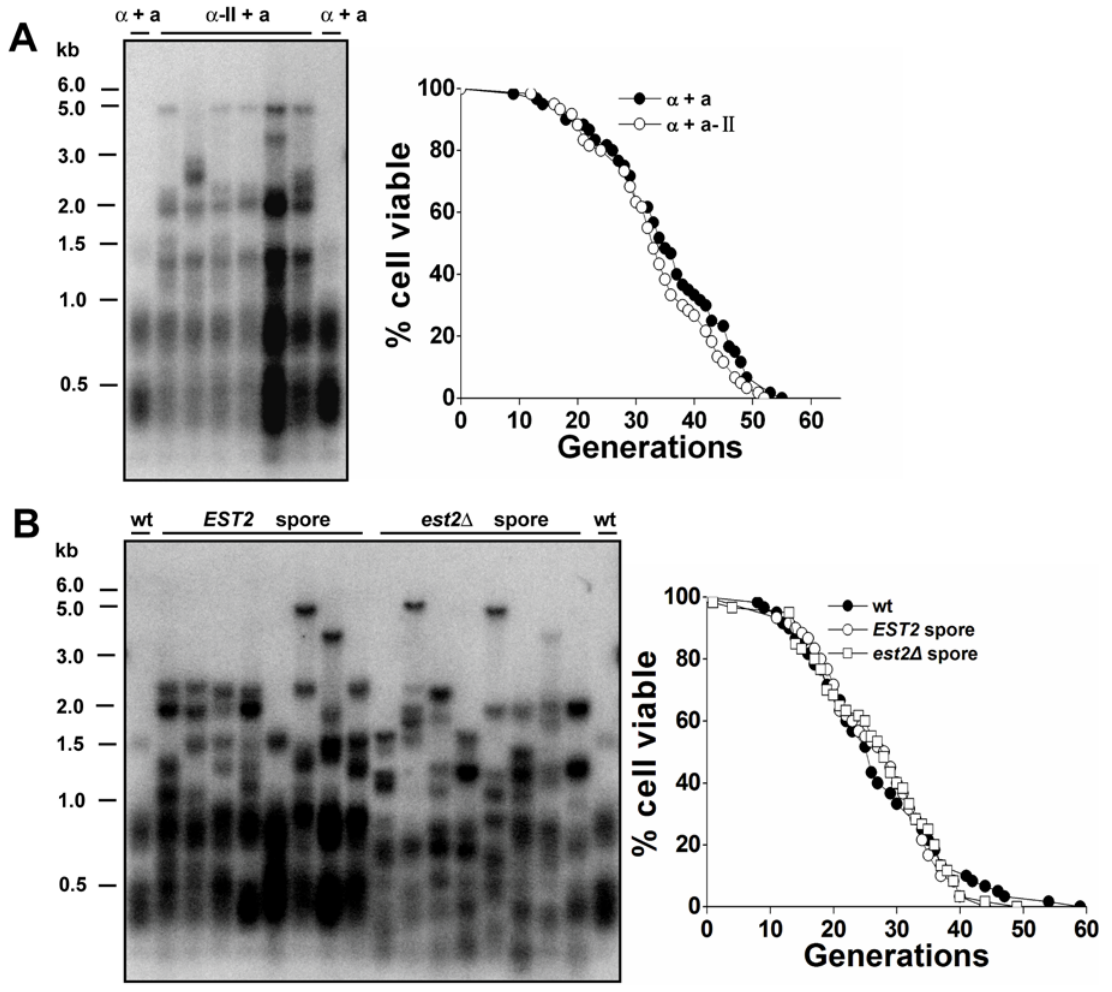
Figure 5. Life span measurement in type II survivors with the presence and absence of telomerase. (A) Telomere length (left) and life span (right) analysis. Diploids (named ‘‘survivor diploids’’, a 2 II + a ) were obtained from mating BY4742 est2 D type II survivor ( MAT a ) with BY4741 ( MATa ) wild-type cells. ( a + a ) refers to wild-type diploids from mating BY4742 ( MAT a ) with BY4741 ( MATa ). (Left) Genomic DNA was digested with 4 bp cutter ( Msp I, Hae III, Hinf I, Alu I). (Right) Mean life span of strains shown: a + a , 35.1 6 10.9 (n=60); a 2 II + a , 33.5 6 9.6 (n=60). (B) Telomere length (left) and life span (right) analysis. Spores were dissected from the above ‘‘survivor diploids’’ and their genotypes were determined. (Left) Genomic DNA was digested with 4 bp cutter ( Msp I, Hae III, Hinf I, Alu I). (Right) Mean life span of strains shown: wild-type, 27.0 6 11.1 (n=60); EST2 spores, 26.8 6 8.9 (n=60); est2 D spores, 26.8 6 10.1 (n=60). suggesting that extra-chromosomal rDNA circles (ERCs) do not contribute to the acceleration of aging process in type II survivors.